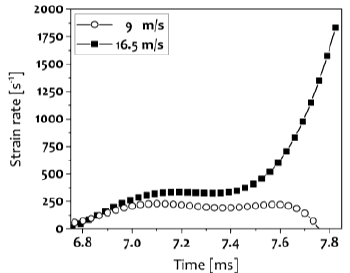
Fig. 5. Strain rate evolution with respect to the time for two different impactor velocities